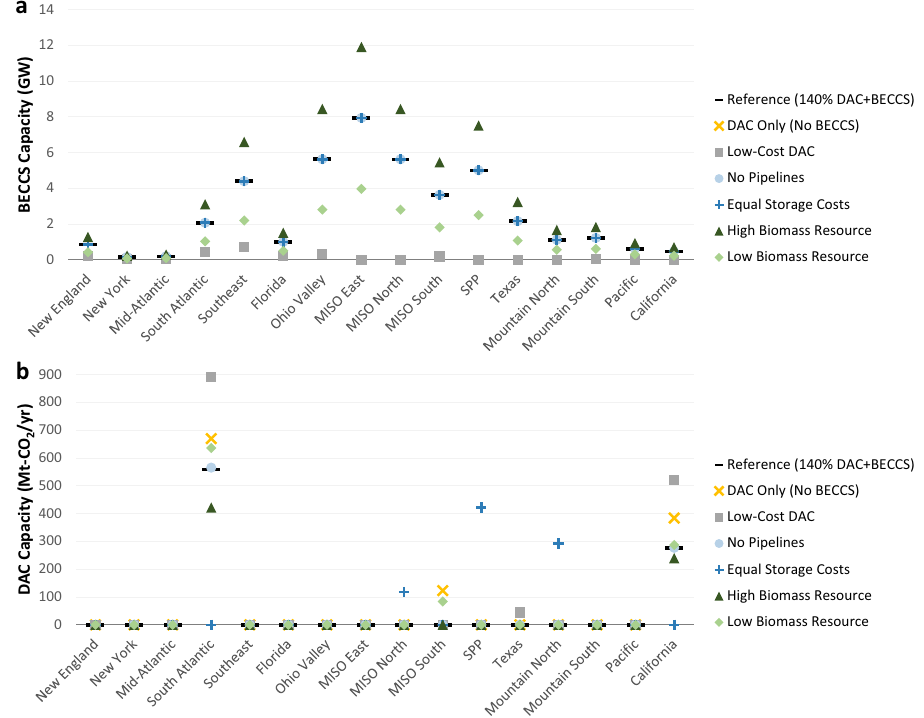
Fig. 8 Regional deployment of CDR technologies across scenarios. Panels show BECCS ( a ) and DAC ( b ) capacity by CDR availability scenario under 140% electric sector CO 2 reductions (relative to 2005 levels). Regional de fi nitions are shown in Supplementary Fig. 1. Source data are provided as a Source Data fi